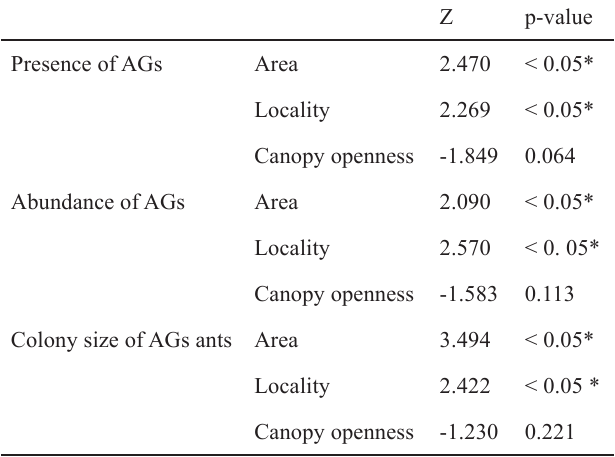
Table 1 . Influence of factors in gap occupation by Ant-Gardens nests of parabiotic ants Camponotus femoratus and Crematogaster levior